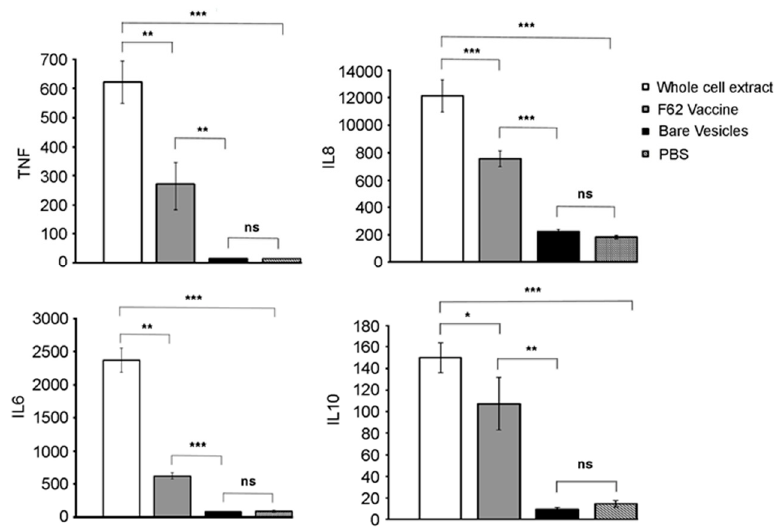
Figure 6. Cytokine induction by SVs, and SVs formulated with N. gonorrhoeae . Human THP-1 cells, grown in RPMI-1640 supplemented with 10% FBS (no antibiotics) were incubated at 37 °C for 24 h with the indicated extracts, broth from each well collected and cytokine expression determined using Invitrogen Human Cytokine Elisa Kits. All assays were performed in triplicate. Statistical significance was determined using a student t -test. *, p < 0.05, **, p < 0.01, ***, p < 0.001. ns is not significant. Error bars represent one standard deviation.